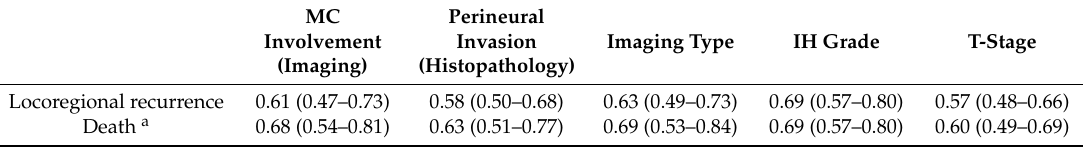
Table 2. Prognostic performance of predictors (Harrell’s C-index, 95% confidence